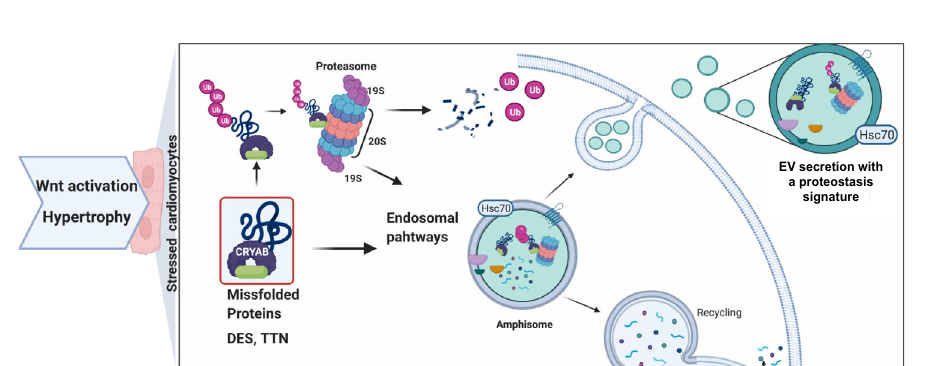
Fig. 8 Scheme summarizing the fi nding in this study. Our study revealed an increased EV-cargo secretion including Z-disk proteins prone to misfolding (DES, TNN), proteasome components and chaperone associated proteins by cardiomyocytes upon Wnt activation and pressure overload induced stress. This was accompanied by a concomitant activation of hypoxia response, which is known to activate EV-mediated processes. This response was more accentuated in early compensatory hypertrophic remodeling, suggesting their contribution to hypertrophic disease adaptation, and may overlap with the endosomal autophagic pathway at the formation of amphisomes, also activated upon stress. It is tempting to speculate that increased cellular stress induces protein misfolding, which triggers an excess of ubiquitination and CRYAB-mediated processes activation and the amphisomes are redirected to the exosomal release. Created with